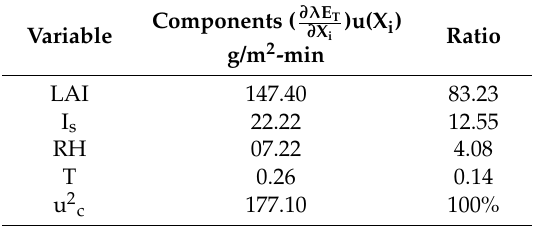
Table 5. The contribution of variable measurement to uncertainty for the Baille ET m equation.